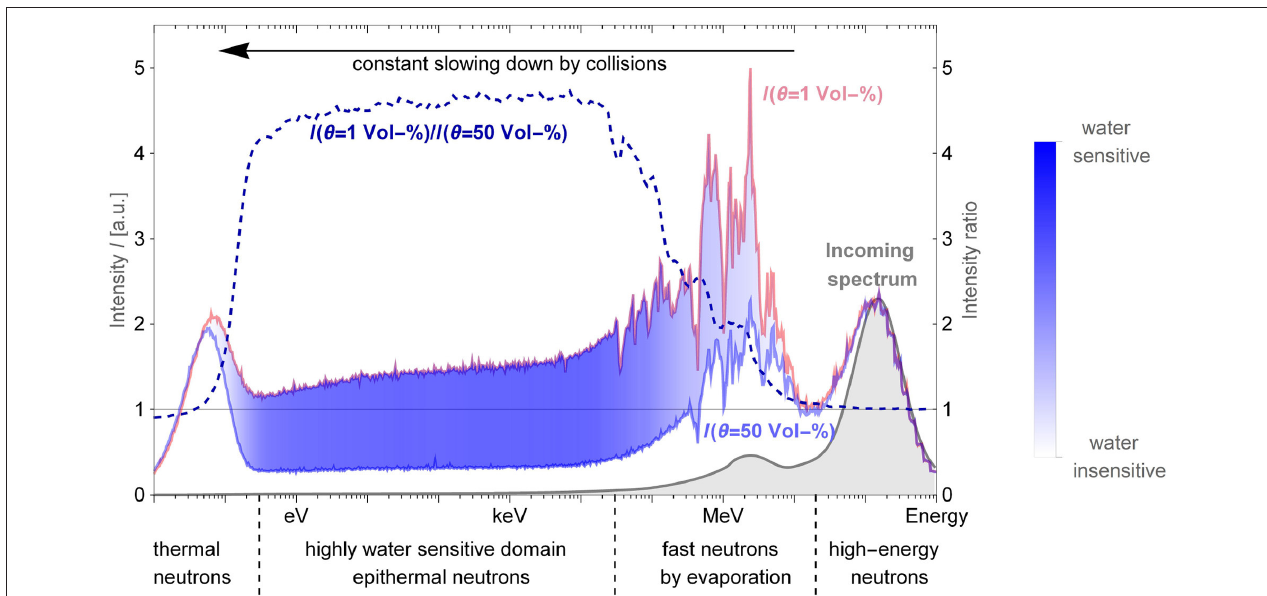
FIGURE 1 | Simulated cosmic-ray neutron spectrum with focus on the hydrogen-sensitive energy domain. The input spectrum, according to Sato (2015) (gray curve), is released in 450m height and propagated toward the soil. Above-ground neutron intensities are shown for dry (light red) and moist conditions (light blue), both at an air humidity of 1g/m 3 . The intensity ratio between dry and moist (dashed blue curve and color-coded filling between the two spectra) reveals the hydrogen-sensitive domain. Neutrons with energies between 0.3eV and 30keV are most suitable as a proxy for the environmental hydrogen content. The simulations were carried out using the Monte Carlo Code MCNP 6.2 ( Goorley et al., 2012) and cross section definitions from the ENDF/B-VIII.0 (Brown et al., 2018) data